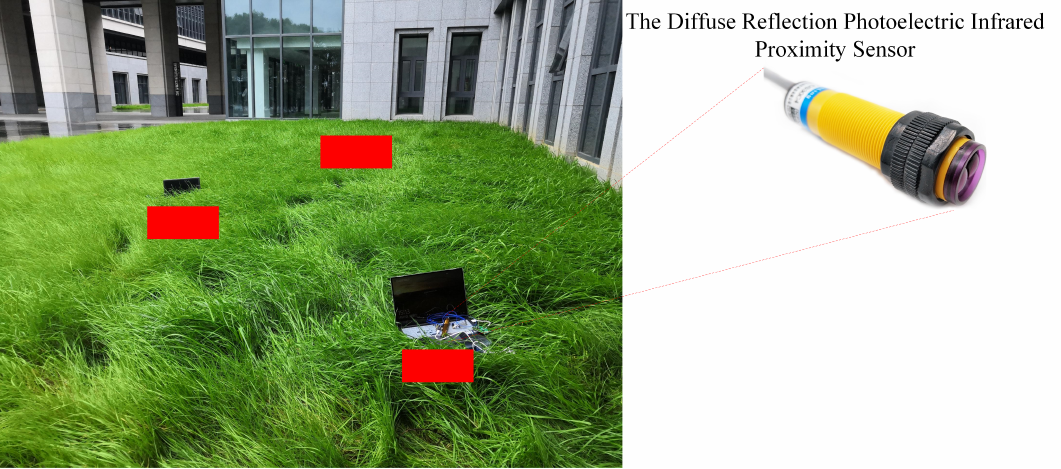
Figure 7. The experimental